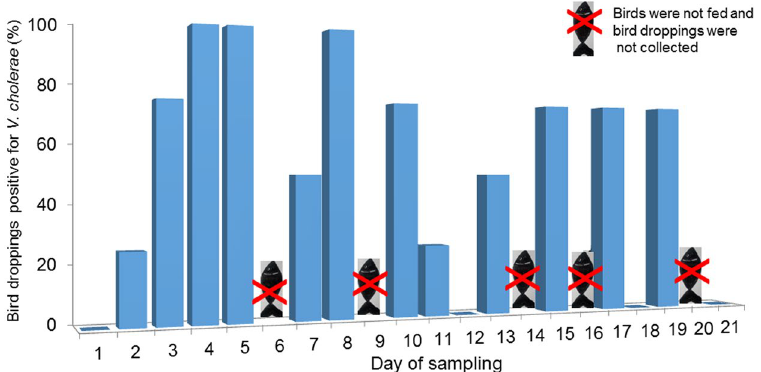
Figure 6. Hand-reared cormorants feeding experiment. Detailed results for treatment A (birds fed on tilapia fish). On day 1, all the bird droppings were negative for V . cholerae . A fish marked X represents days when the birds were not fed and droppings were not collected (n =